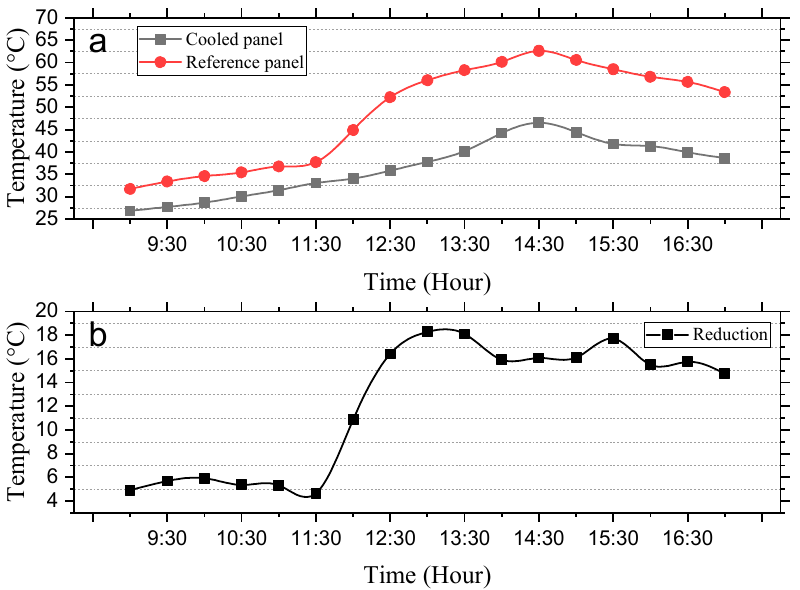
Figure 6. ( a ) Temperature ( b ) change in temperature for the cooled and referenced module.